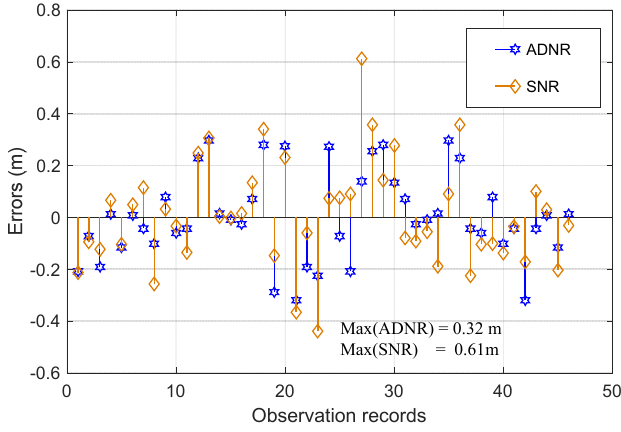
Figure 8. Error fluctuation in the two algorithms.